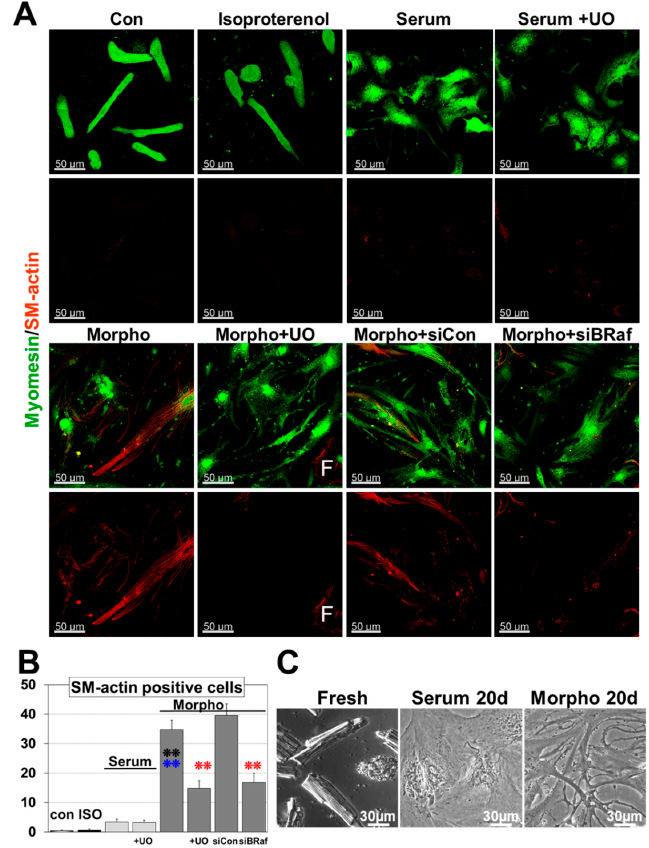
Figure 2. Morphogen but not serum induces Ras / Raf / MEK / ERK cascade (MAPK)-dependent remodeling and dedifferentiation. ( A ) Myomesin and α -smooth muscle actin (SM-actin) fluorescence images after 6-day treatment. SM-actin serves as marker for dedifferentiation / fetal remodeling. Primary cultures of adult cardiomyocytes were untreated or treated with 20 nM isoproterenol (ISO), serum (Serum) and morphogens (Morpho). UO126 (5 µ M) was added as an inhibitor of the MAPK pathway ( + UO) 1h before experimental start. Note that knock-down of B-Raf (siBRaf) was performed for three days prior to stimulation. Single and double stars indicate p < 0.01 and p < 0.001, respectively. Black signs refer statistically to Con, blue signs to serum, and red compares Morpho (Morpho, Morpho siCon) statistically with and without UO / siB-Raf ( + UO, siBRaf). A SM-actin positive fibroblast acts as positive control and is indicated by a white F. ( B ) Quantitative evaluation of the number of SM-actin positive cells and statistical analysis of ( A ). ( C ) Phase-contrast images of freshly isolated cells (Fresh), as well as Serum- (Serum 20 d) and Morpho-treated (Morpho 20 d) cardiomyocytes after 20 d showing long-term